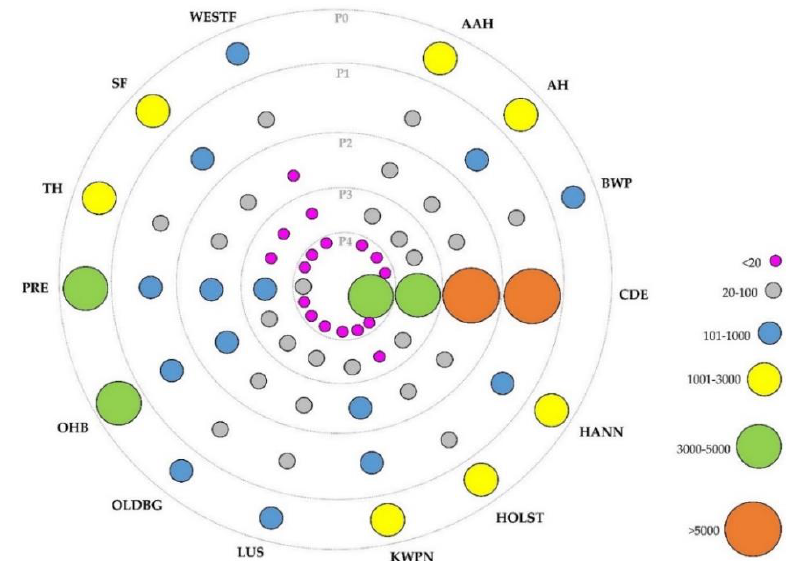
Figure 1. Distribution of horse breeds from the Caballo de Deporte Español Official Stud Book according to the period considered. Different sizes and colors of the circles indicate the number of animals of a certain breed within periods. Where AAH is Anglo-Arab Horse, AH is Arab Horse, BWP is Belgian Warmblood, CDE is Caballo de Deporte Español, HANN is Hanoverian Horse, HOLST is Holsteiner Horse, KWPN is KWPN Horse, LUS is Lusitano Purebred, OLDBG is Oldenburg Horse, OHB is Other Horse Breeds, PRE is Pura Raza Española, TH is Thoroughbred, SF is Selle Français, WESTF is Westphalian Horse; P 0 is the period with animals born before 2000, P 1 between 2000 and 2004, P 2 between 2005 and 2009, P 3 between 2010 and 2014, and P 4 after 2015.